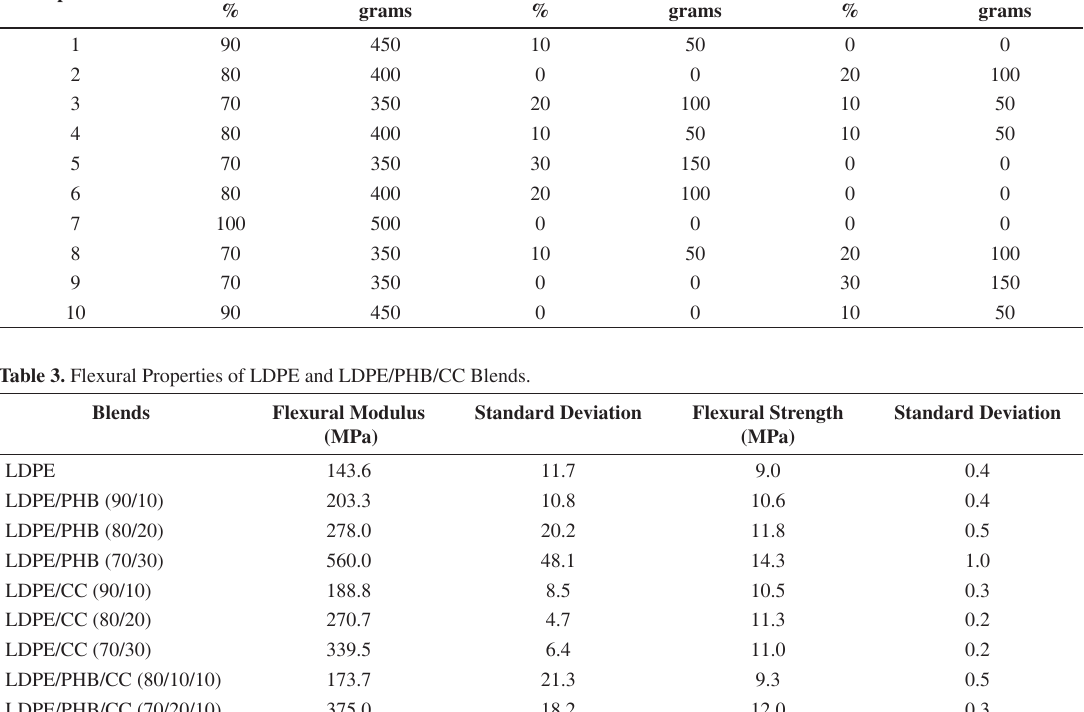
Table 2. Composition of LDPE/PHB/CC mixtures. Sample Code